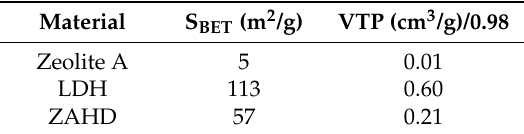
Table 2. Textural results for the synthesized materials.